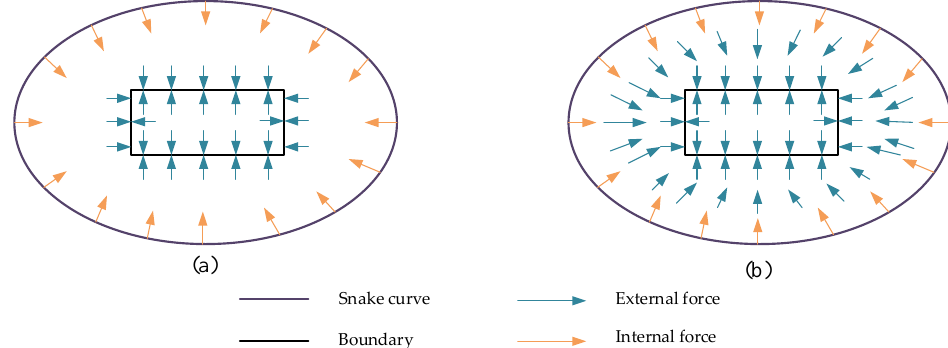
Figure 2. ( a ) Snake with image gradient as external force. ( b ) Snake with GVF as external force.